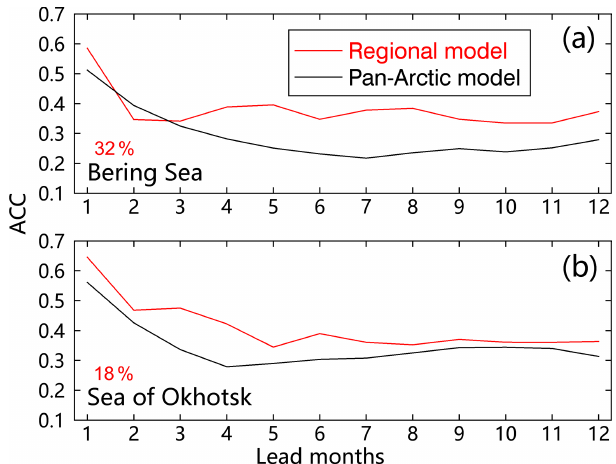
Figure 9. Cross-validated model skills of the regional Markov model vs. the pan-Arctic Markov model. (a) The skills are mea- sured by the ACC between predictions and observations with trends from 1980 to 2020 as a function of lead months in the Bering Sea. Panel (b) is the same as (a) except for the Sea of Okhotsk. The red numbers in the bottom left of each panel represent the mean regional model skill improvements from the pan-Arctic